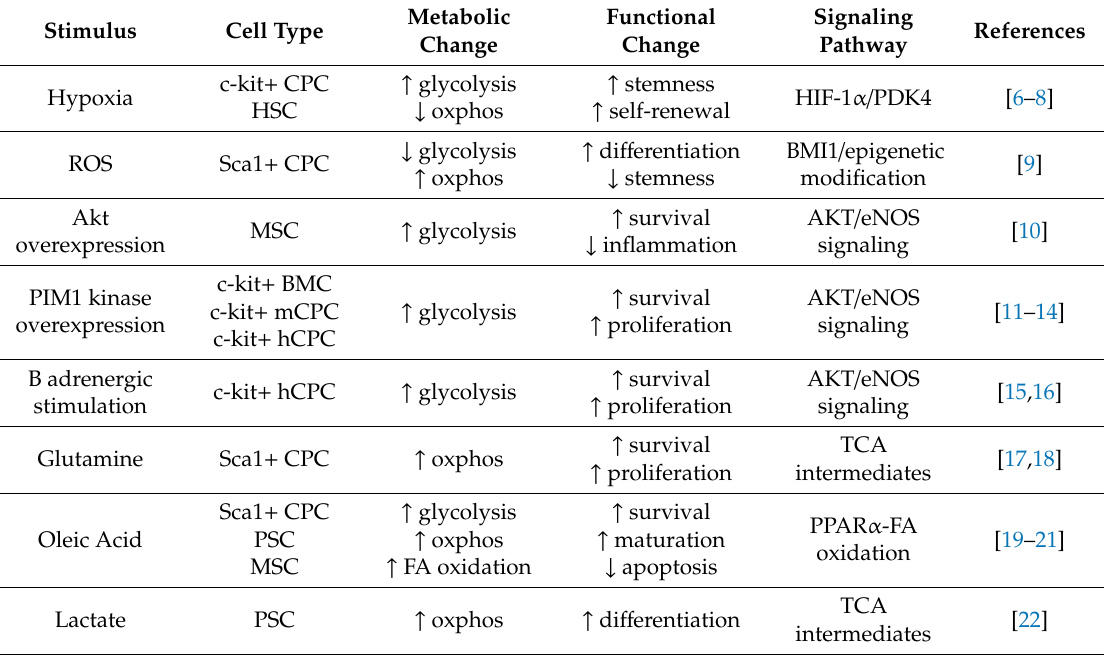
Table 1. Metabolic adaptations and functional changes of pluripotent and adult stem cells in response to specific environmental